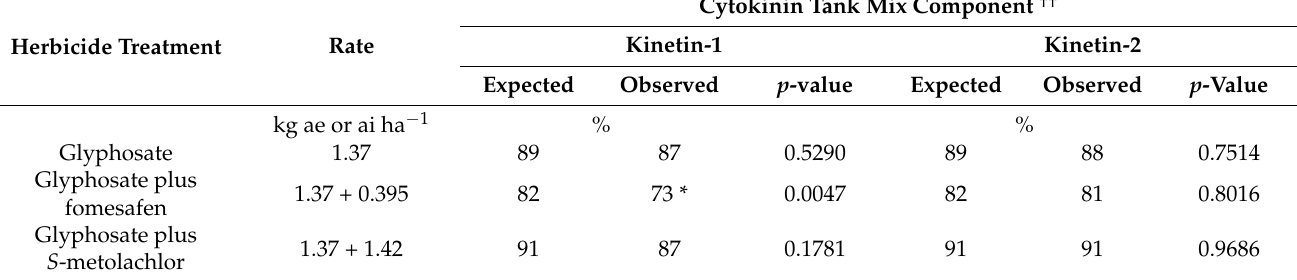
Table 3. Antagonistic responses for barnyardgrass control 14 d after treatment (DAT) with tank mixtures of POST herbicide treatments and cytokinin products applied at the V3 growth stage to soybean in Stoneville, MS, during 2015 and 2016 †,‡ .